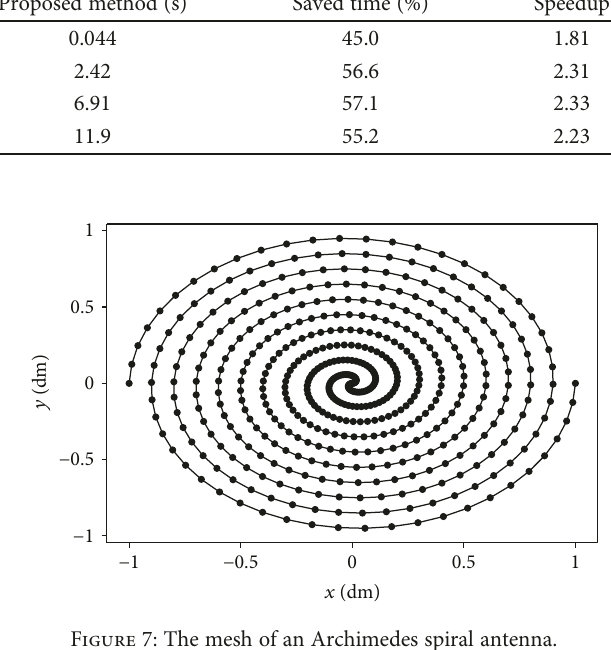
Figure 7: The mesh of an Archimedes spiral antenna.